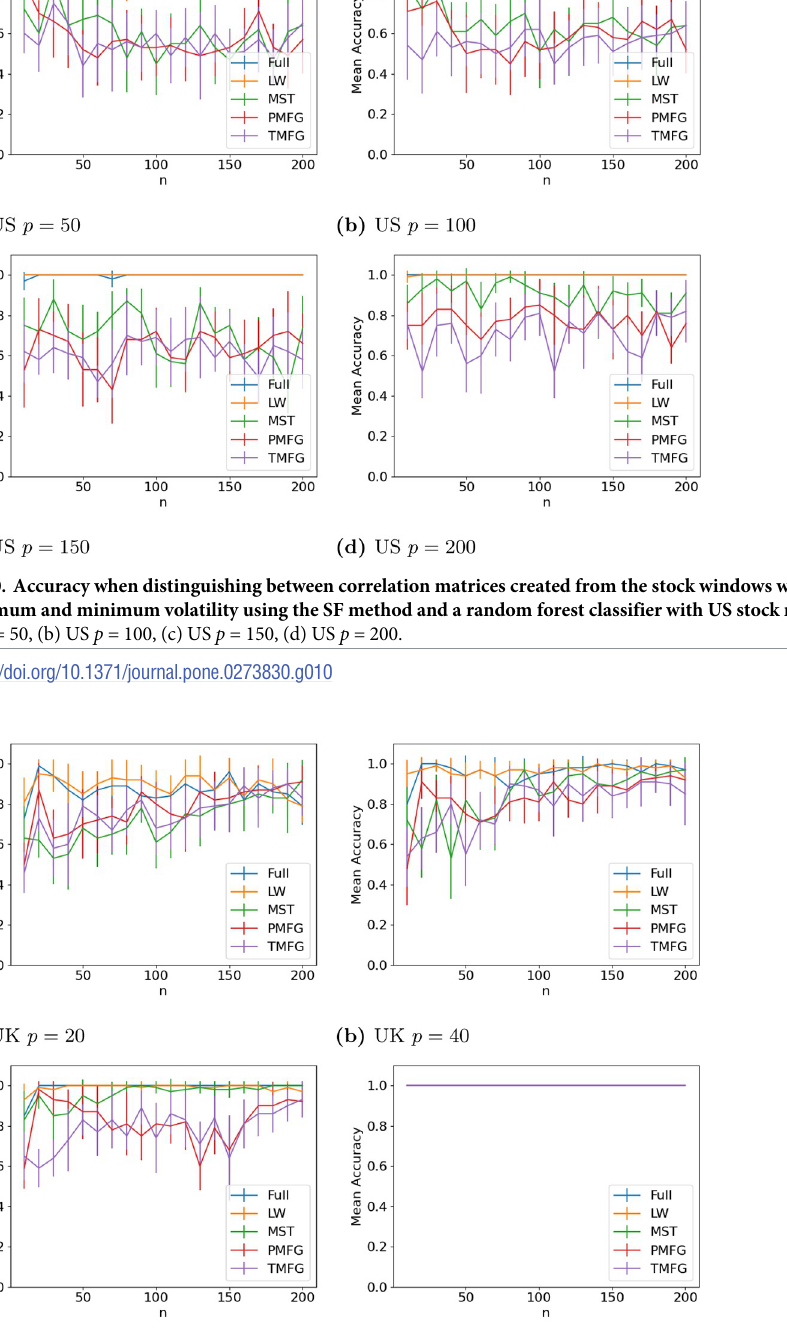
PLOS ONE | https://doi.org/10.1371/journal.pone.0273830 September 7,